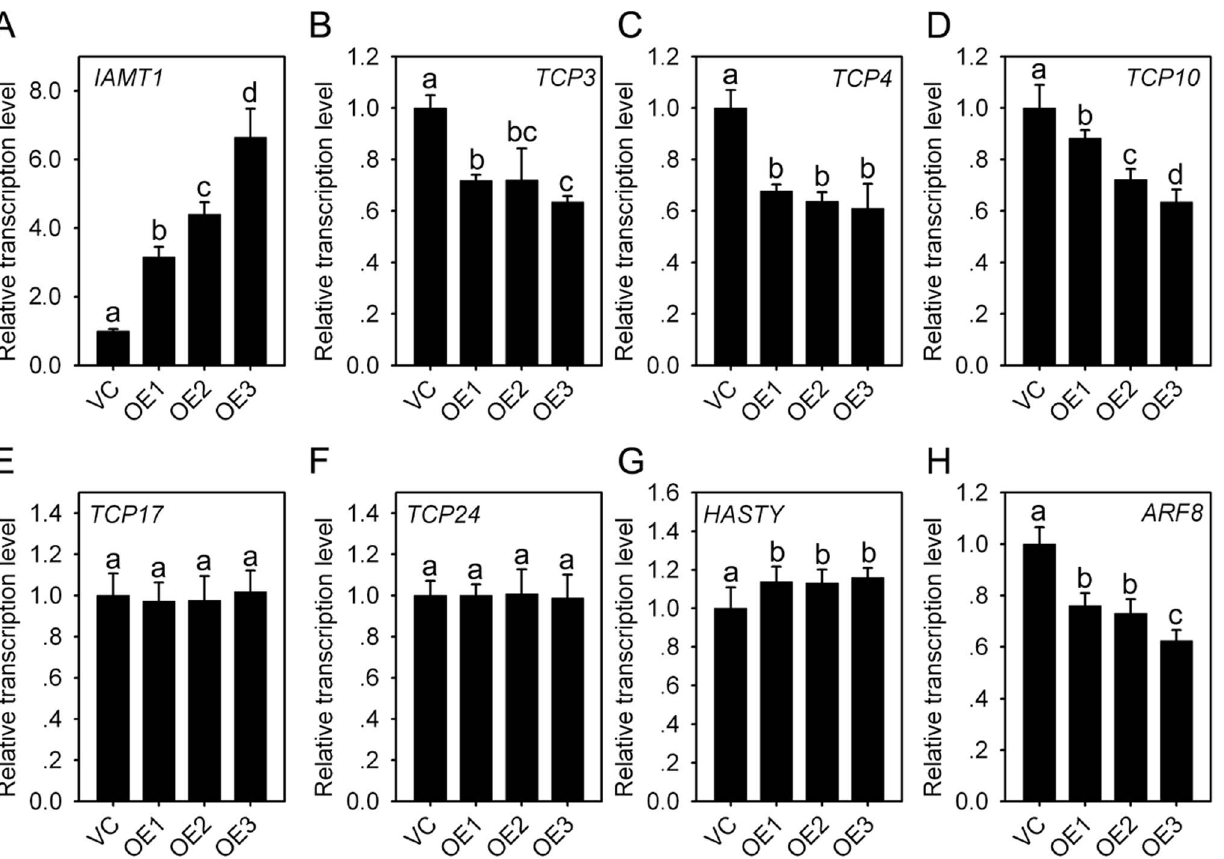
Figure 7. TaWRKY71-1 alters the expression of IAMT1 -mediated leaf curvature genes. VC, Vector control; OE1–3, Three independent transgenic Arabidopsis lines overexpressing TaWRKY71-1 . The leaves of four-week old Arabidopsis seedlings were harvested for real-time PCR. Arabidopsis actin gene ACTIN2 was used as the internal reference. The graphs represent one of the same results from three independent experiments. Data present as mean 6 standard deviation. Columns without the same lowercase letter are significantly different using the lowest significant difference test of one-way ANOVA ( P , 0.05).